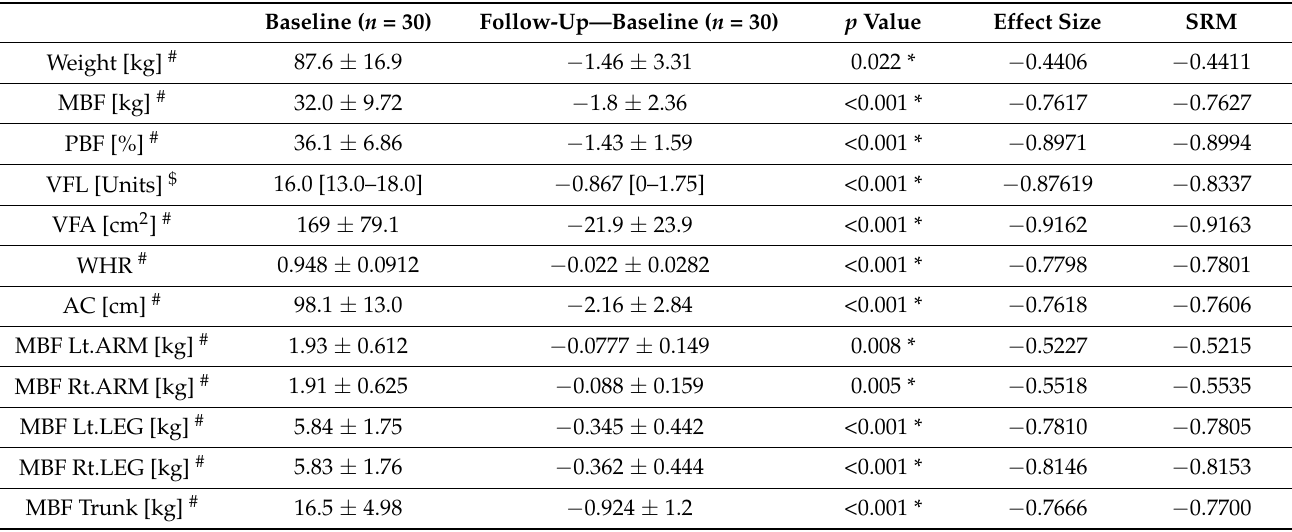
Table 1. Body mass composition.